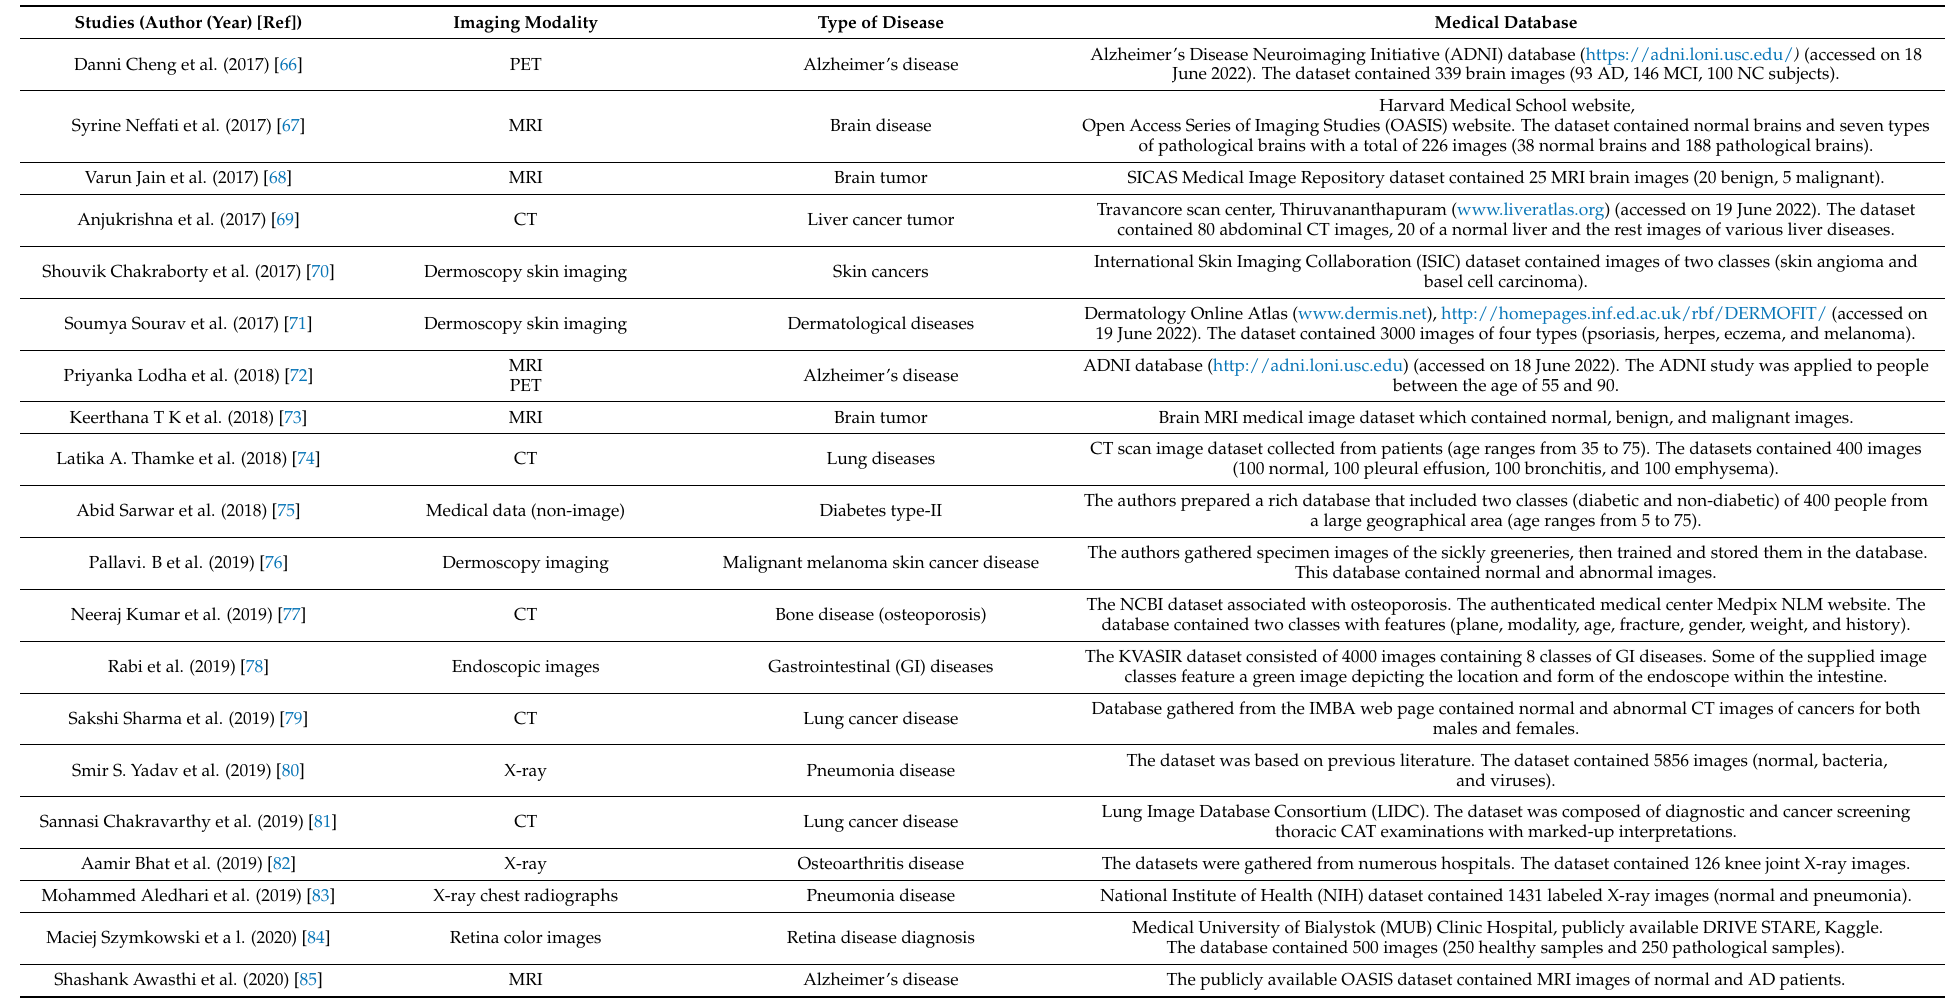
Table 1. Distribution of studies for different medical imaging